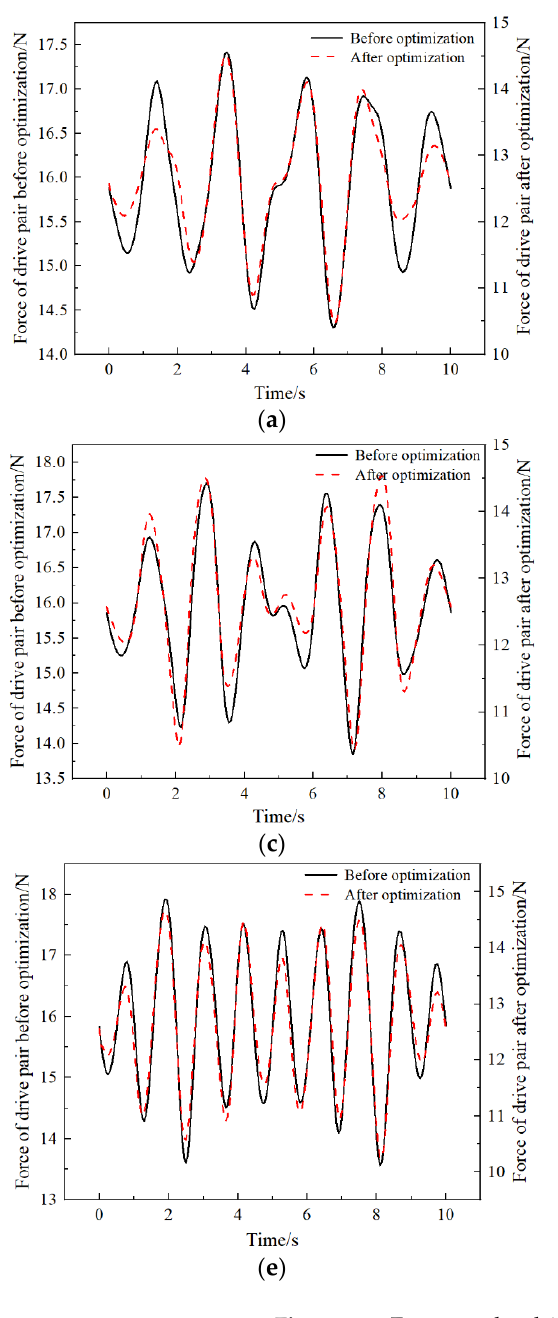
Peak Force before Project Optimization/N